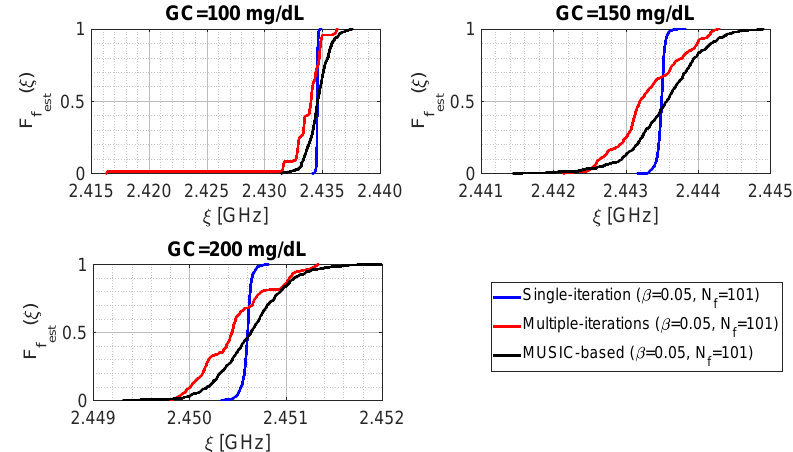
Figure 8. Cumulative distribution functions of the resonant frequency estimate for the three sharpen- ing algorithms, as a function of the glucose concentration. Table 1. Statistics of f est for three different values of the glucose concentration ( GC ). Symbols µ , σ